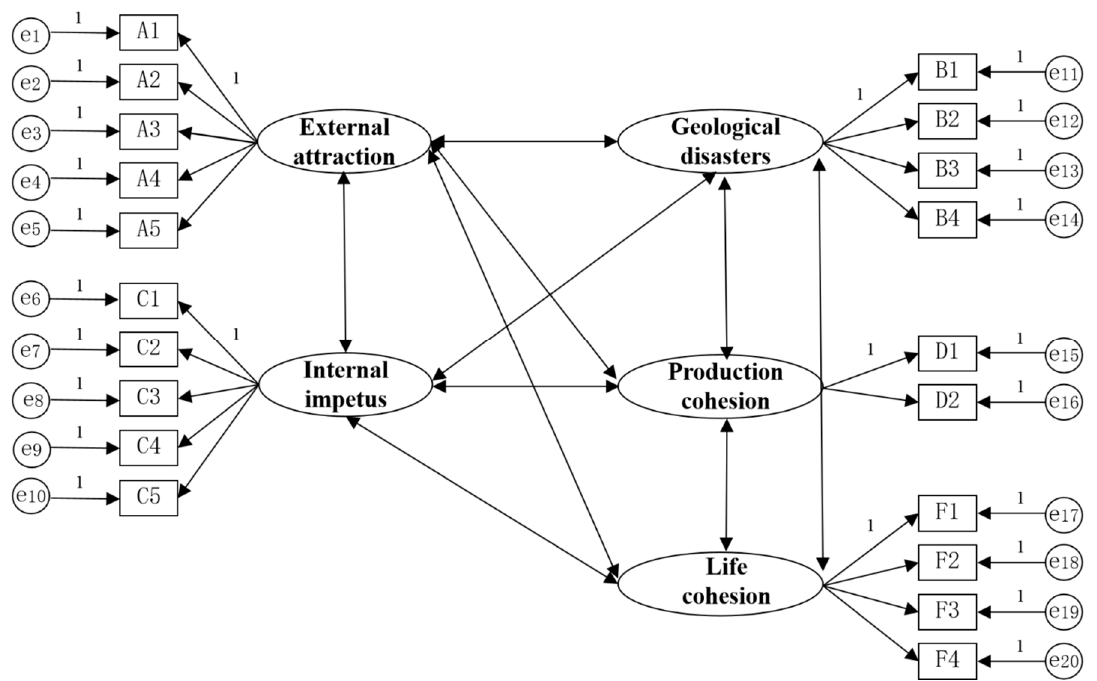
Figure 3. Initial SEM structural equation.